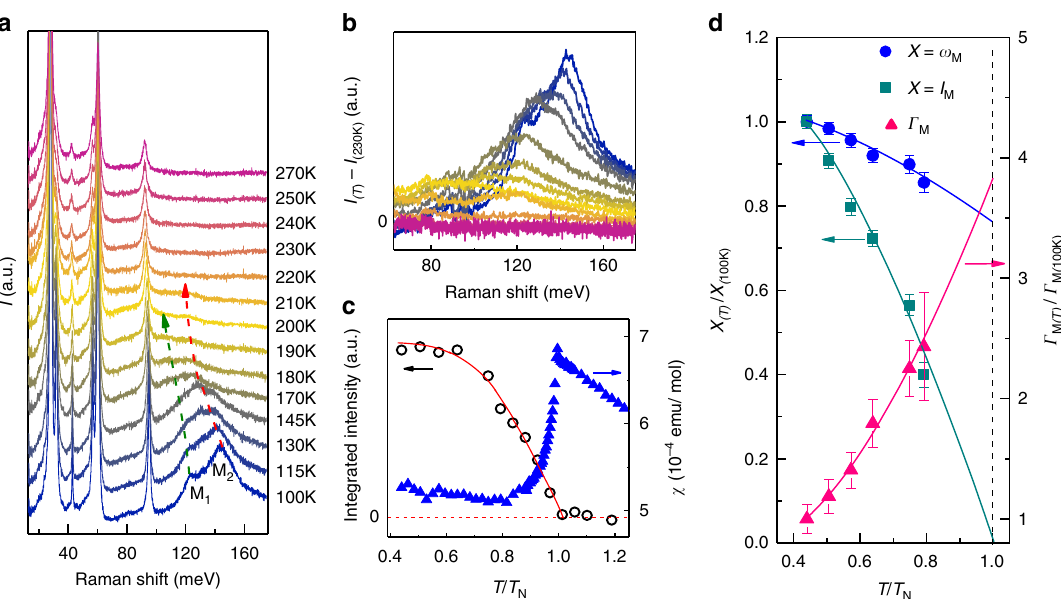
Fig. 2 T -dependent Raman spectra of Cd 2 Os 2 O 7 . a , b Raman intensities ( I ) and difference spectra ( I T - I 230K ) of Cd 2 Os 2 O 7 at various temperatures from 100 K to 270 K. The intensity difference spectra were obtained by fi rst removing the T 2g (4) phonon contribution and then taking the difference between the Raman intensity at a particular temperature and 230 K (just above T N = 227 K). The dashed arrows are guides for the eye and represent the evolution of the two-magnon features with T . Note that the two-magnon peaks M 1 and M 2 show a much stronger T- dependence than the phonon peaks. c T -dependence of the integrated intensity of the two-magnon peaks in the range of 75 – 165 meV ( open black circles ) and the magnetic susceptibility at H = 20 kOe measured after zero- fi eld cooling ( fi lled blue triangles ). The red solid line is a guide for the eye. Both quantities show clear anomalies at T N . d T -dependence of the normalized frequency ( ω M — fi lled blue circles ), intensity ( I M — fi lled dark cyan squares ) and FWHM ( Γ M — fi lled pink triangles ) of the M 2 peak. These parameters were derived by fi tting M 2 with a Lorentzian lineshape. The error bars represent the standard deviation in the data fi tting procedure.The solid lines are guides for the